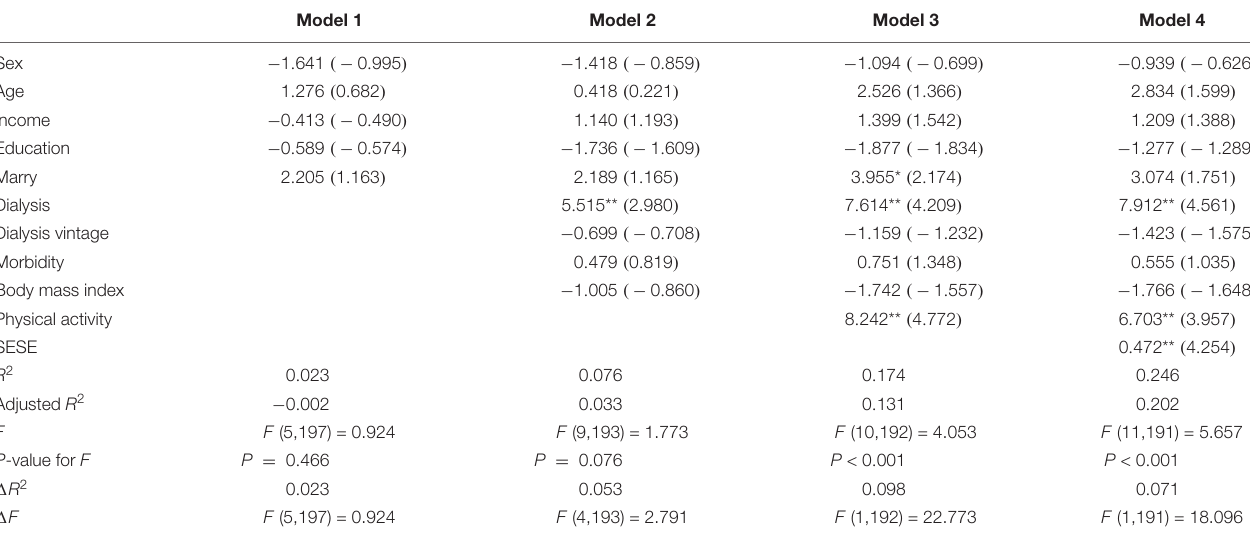
TABLE 2 | Hierarchical linear regression for prediction of health-related quality of life